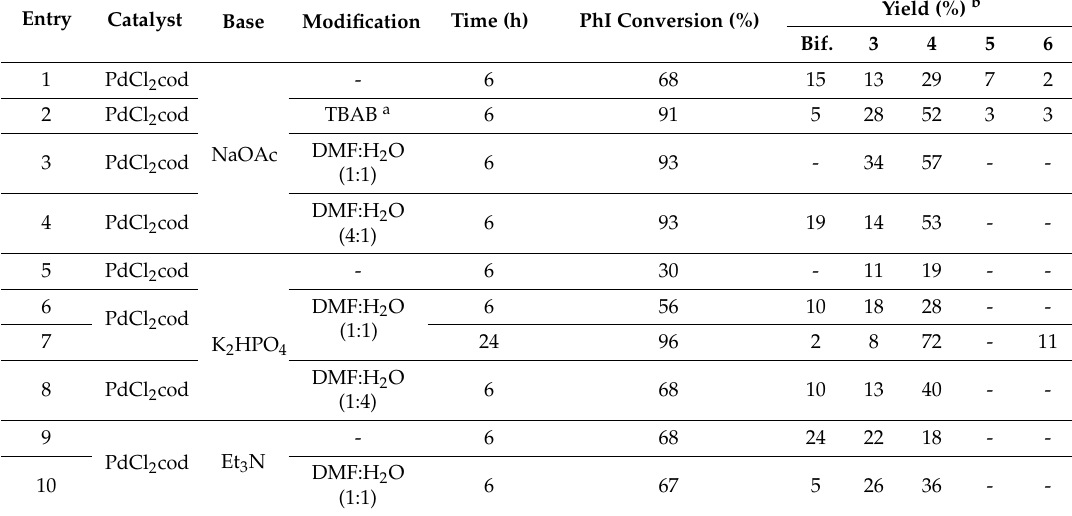
Table 5. Results of the Heck reaction of cinnamyl alcohol with iodobenzene.